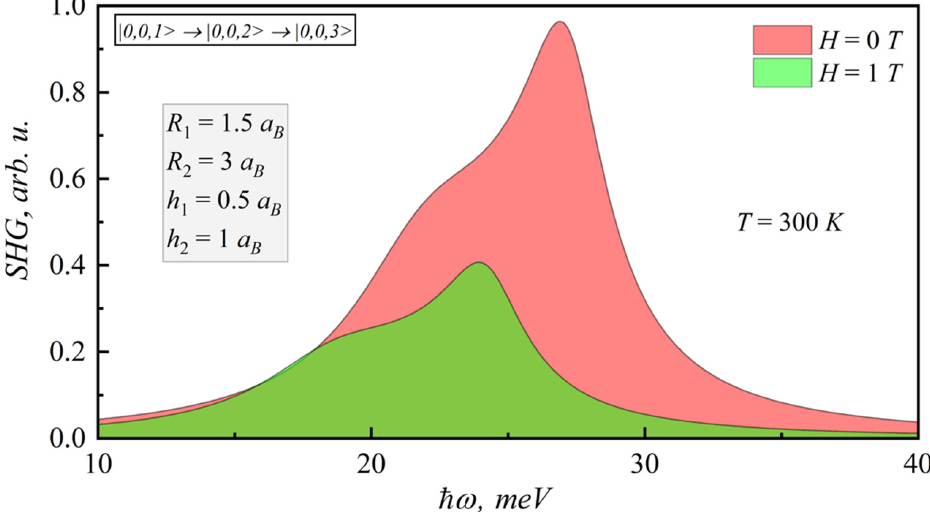
Figure 9. Dependence of SHG coefficient on photonenergy for different magnetic fields.